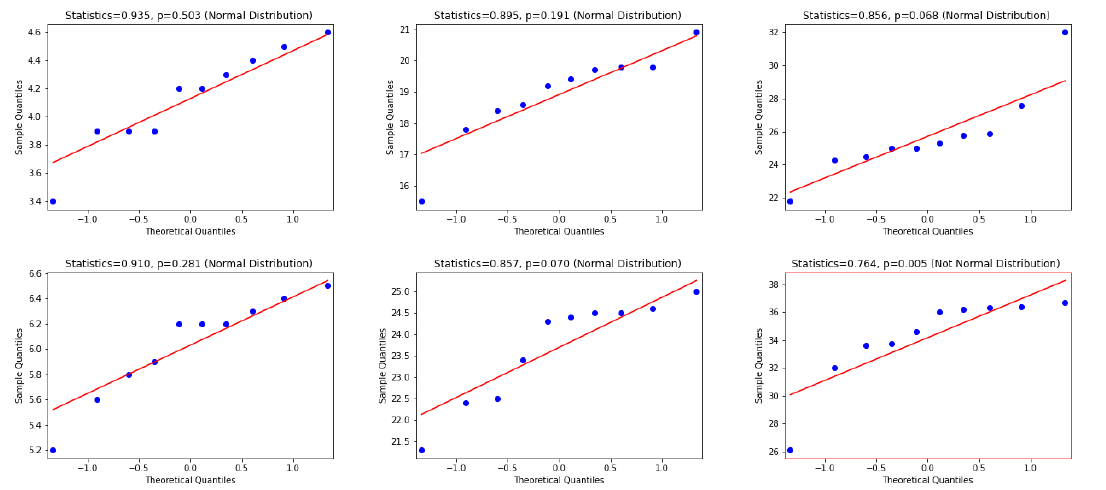
Figure 6. This figure provides Quantile–quantile plots with the p -values of the Shapiro–Wilk test for the differences between CER, WER, and SER results in Section 5.2 represents the distributions of